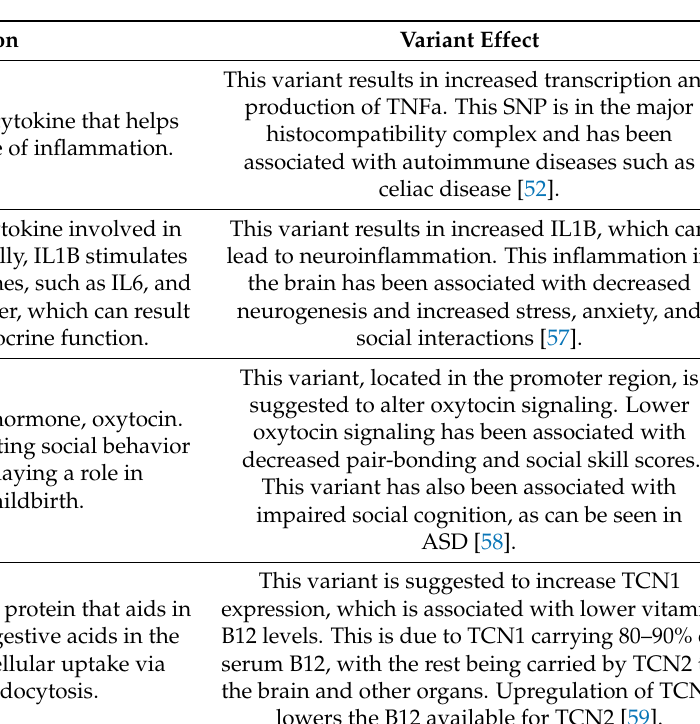
Table 3. A sampling of genetic variants that were found in the patients described above. Superscripts next to the gene symbol represent the presence of the variant in the corresponding patient’s case (1 = Patient 1, 2 = Patient 2,